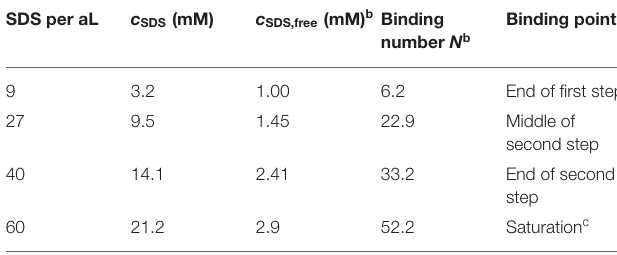
TABLE 1 | Concentration of SDS used for different samples a